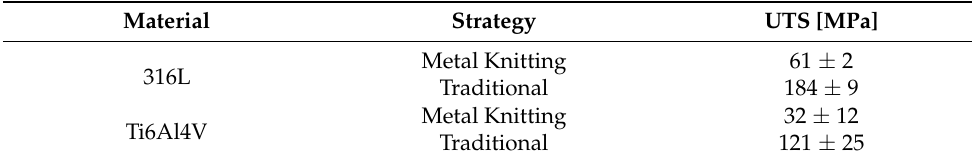
Table 5. CSAM produced by traditional and Metal Knitting UTS results.